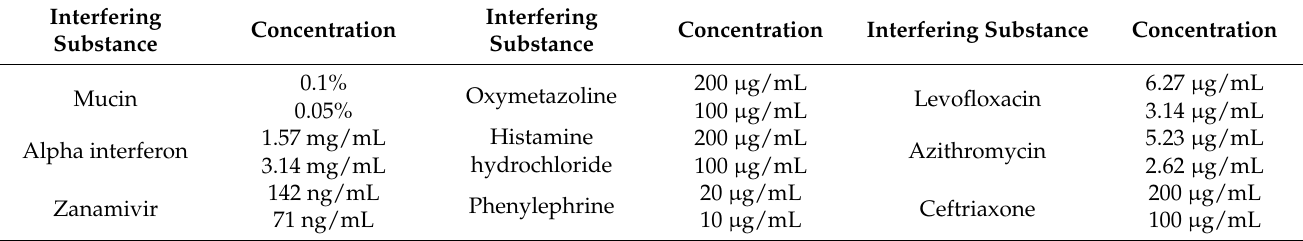
Table 1. Concentration table of interfering